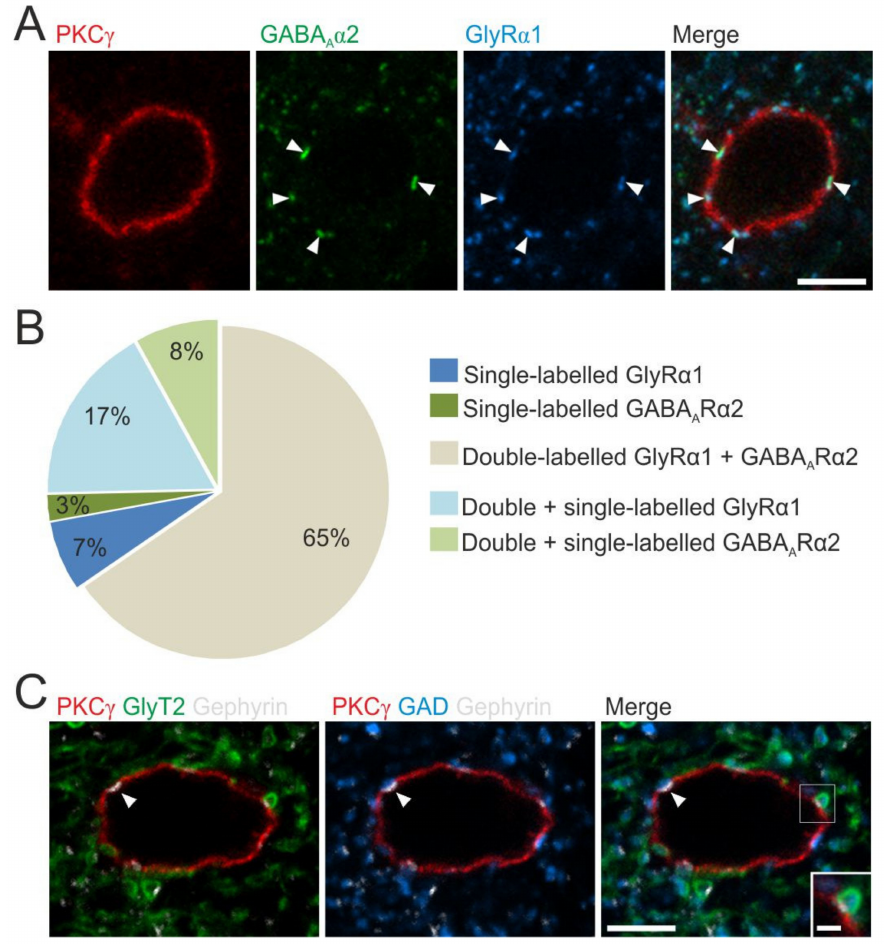
Figure 4. Inhibitory receptors and synapses on lamina II i PKC γ + interneurons. ( A ) Confocal im- ages showing a PKC γ + interneuron (red) with GABA A R α 2 (green) and GlyR α 1 (blue) labelings. The merged image shows that these inhibitory receptor subunits were colocalized on the cell body (arrowheads). Scale bar = 5 µ m. ( B ) Proportions of PKC γ + interneurons that display GABA A ergic and/or glycinergic receptors subunits ( n = 75). ( C ) Confocal image of a single optical section through a part of lamina II i , scanned to reveal PKC γ (red), gephyrin (white), GlyT2 (green), and GAD (blue). Gephyrin labeling indicates the localization of inhibitory synapses on the PKC γ cell body, and GlyT2 and GAD labelings show the terminal synaptic boutons. The arrowhead indicates a synapse from a GAD-positive GlyT2-negative bouton, while the inset (corresponding to the box magnification, scale bar = 1 µ m) shows a synapse from a bouton that is positive for both GAD and GlyT2 (scale bar = 5 µ